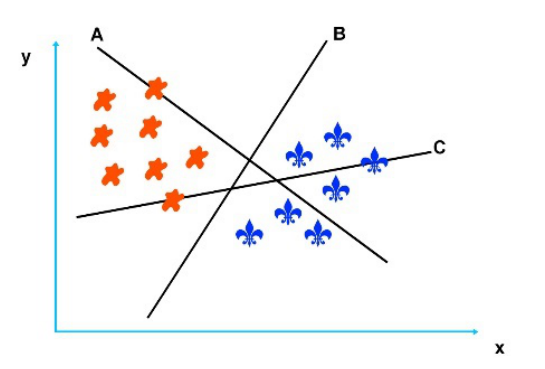
Figure 1. SVM with the different hyperplane